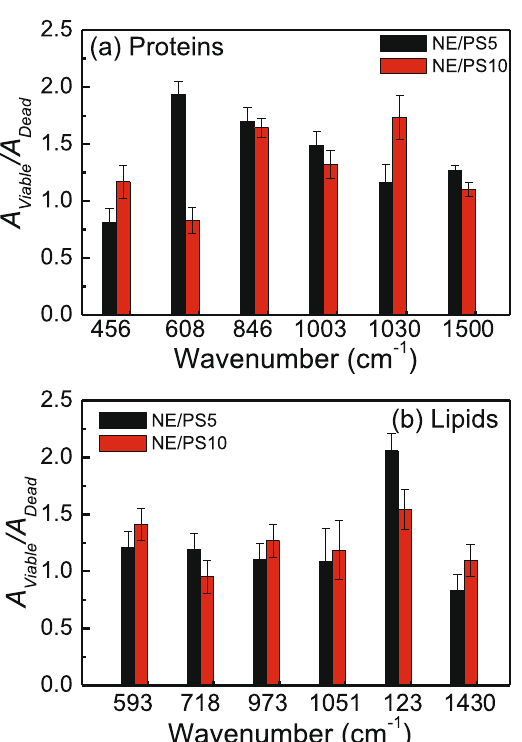
Figure 4. SERS spectra of 4T1 breast cancer cells groups: control and viable and dead cells PDT treated using the NE/PS10 complex. Solid lines are spectral averages.